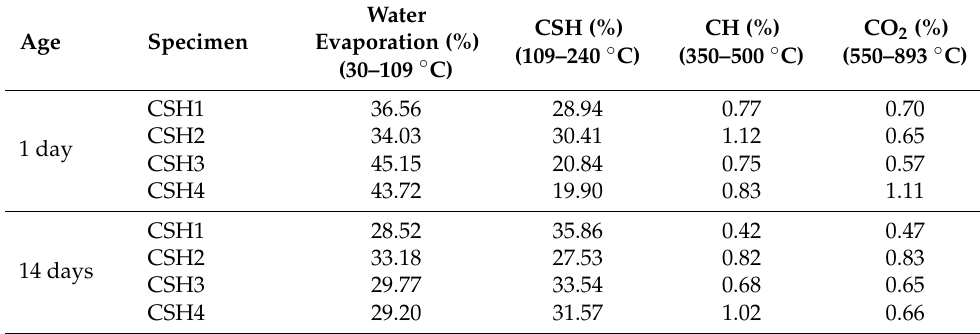
Table 1. Weight loss percentages due to thermal decompositions of the CSH